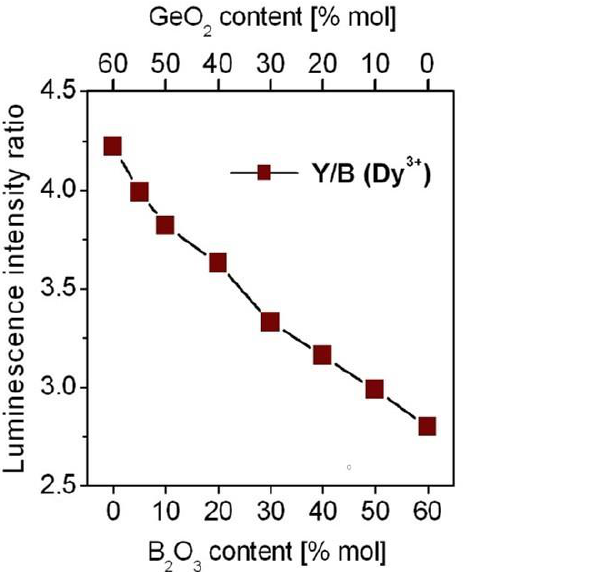
Figure 7. Luminescence intensity ratio Y/B (on left ) and the peak stimulated emission cross-section for the 4 F 9/2 → 6 H 13/2 transition of Dy 3+ ions in borogermanate glasses (on right ).